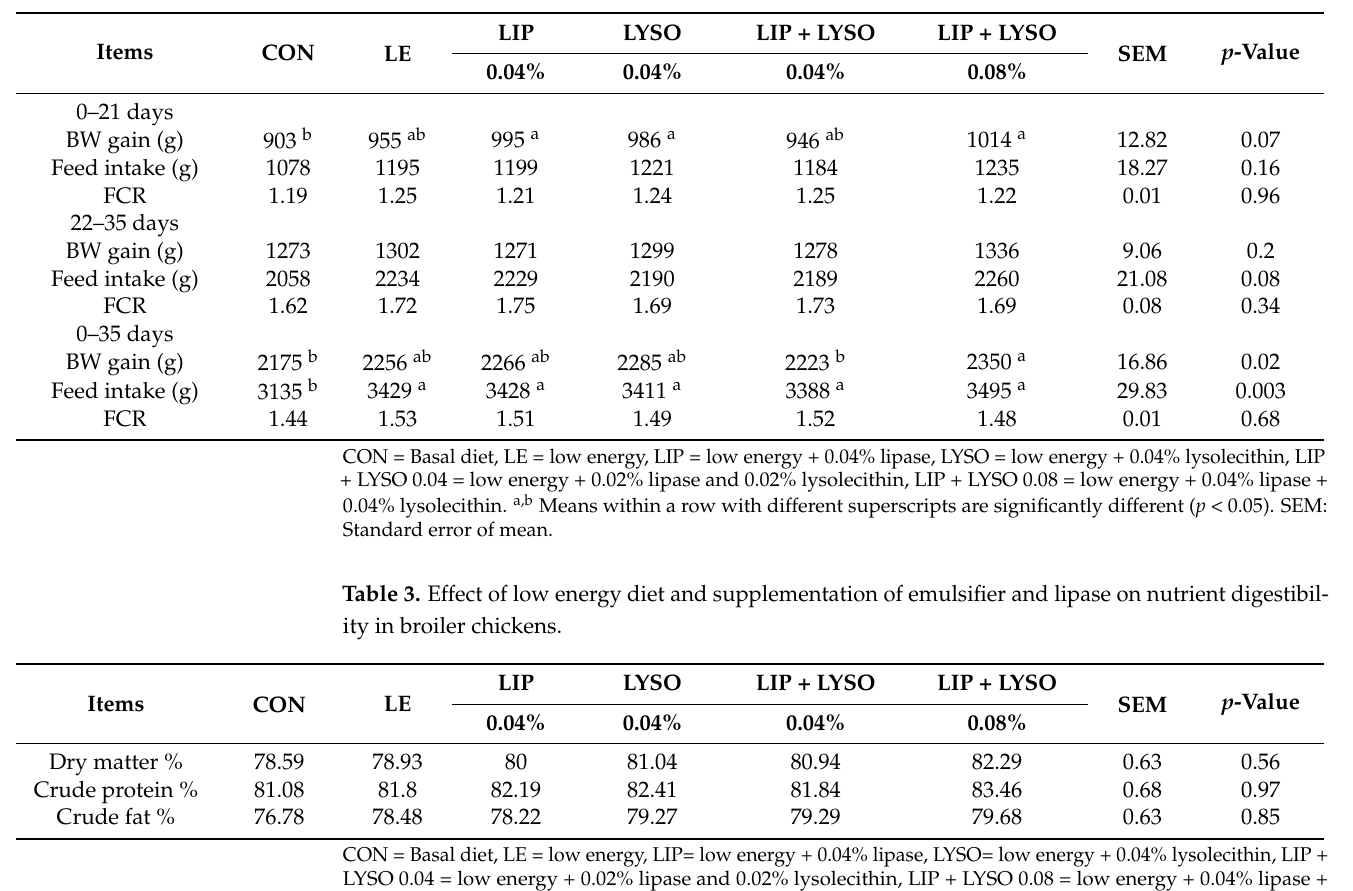
Table 2. Effect of low energy diet and supplementation of emulsifier and lipase on growth perfor- mance of broiler chickens.